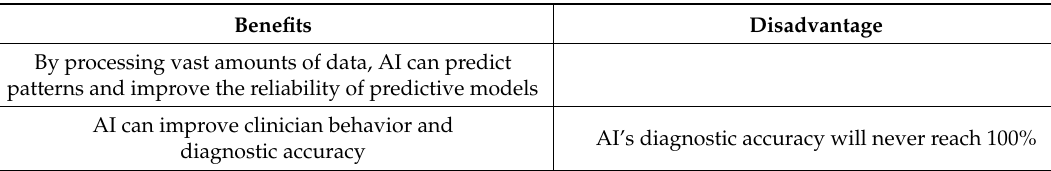
Table 1. Benefits and disadvantage of